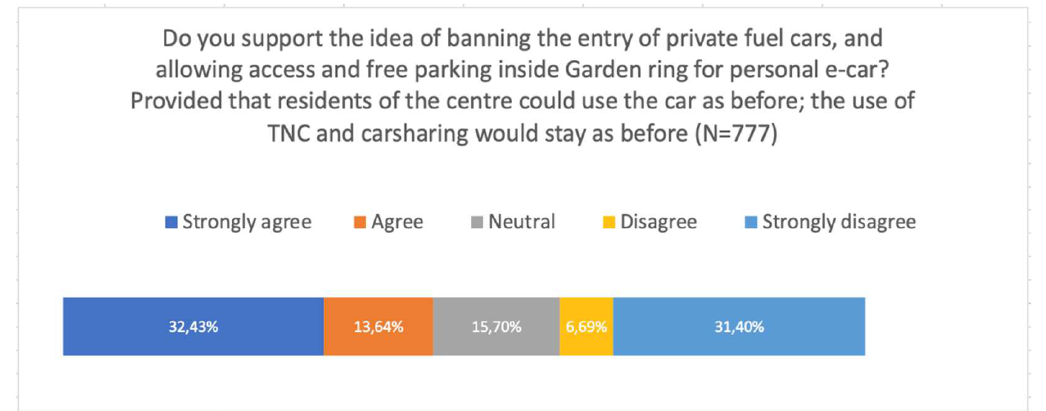
Figure 10. Future intention of respondents to banning area inside Garden Ring (city centre) for pri- vate internal combustion engine vehicles (N = 777).